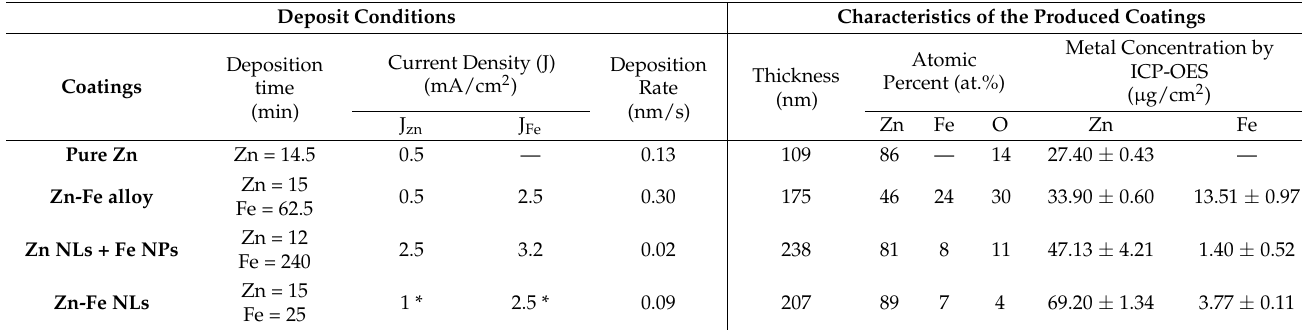
Table 2. Experimental details used during deposition, thickness, atomic composition, and final mass concentration of Zn and Fe in the produced nanostructures.